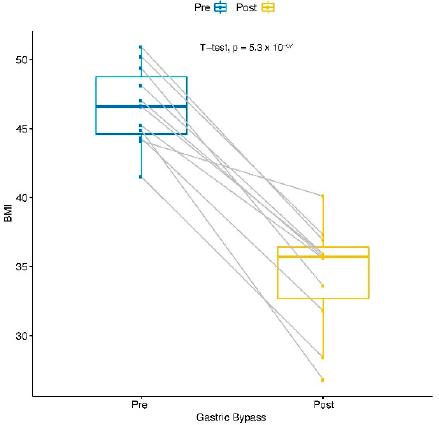
Figure 2 . Comparison of weight loss in pre- and post-surgery conditions. For a better comparison, BMI was used to monitor changes in weight loss.